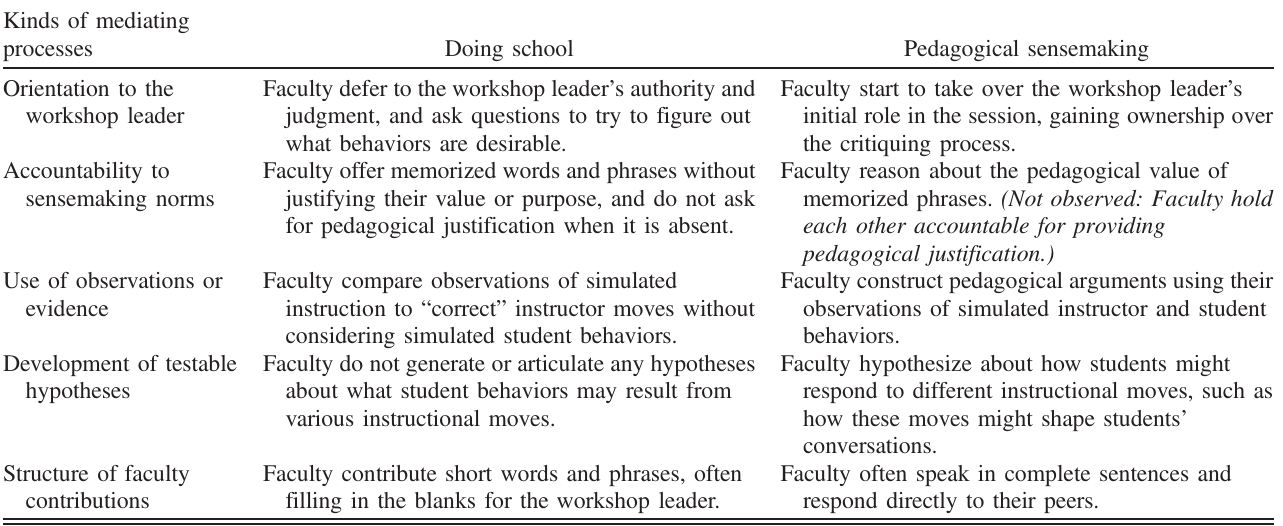
TABLE VI. Observed markers of faculty engaging in doing school and pedagogical sensemaking. Kinds of